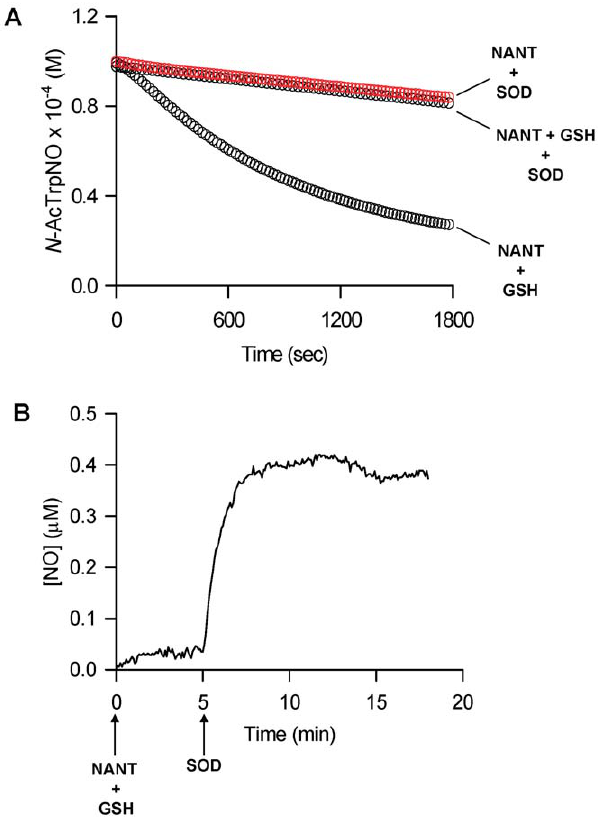
Figure 3. Effect of superoxide dismutase (SOD) on the GSH- induced decomposition of NANT and NO production. ( A ), Time- course of NANT decomposition in the presence of GSH with or without SOD; representative of three experiments. ( B ), NO formation in solution upon incubation of NANT with GSH and SOD; representative of 4